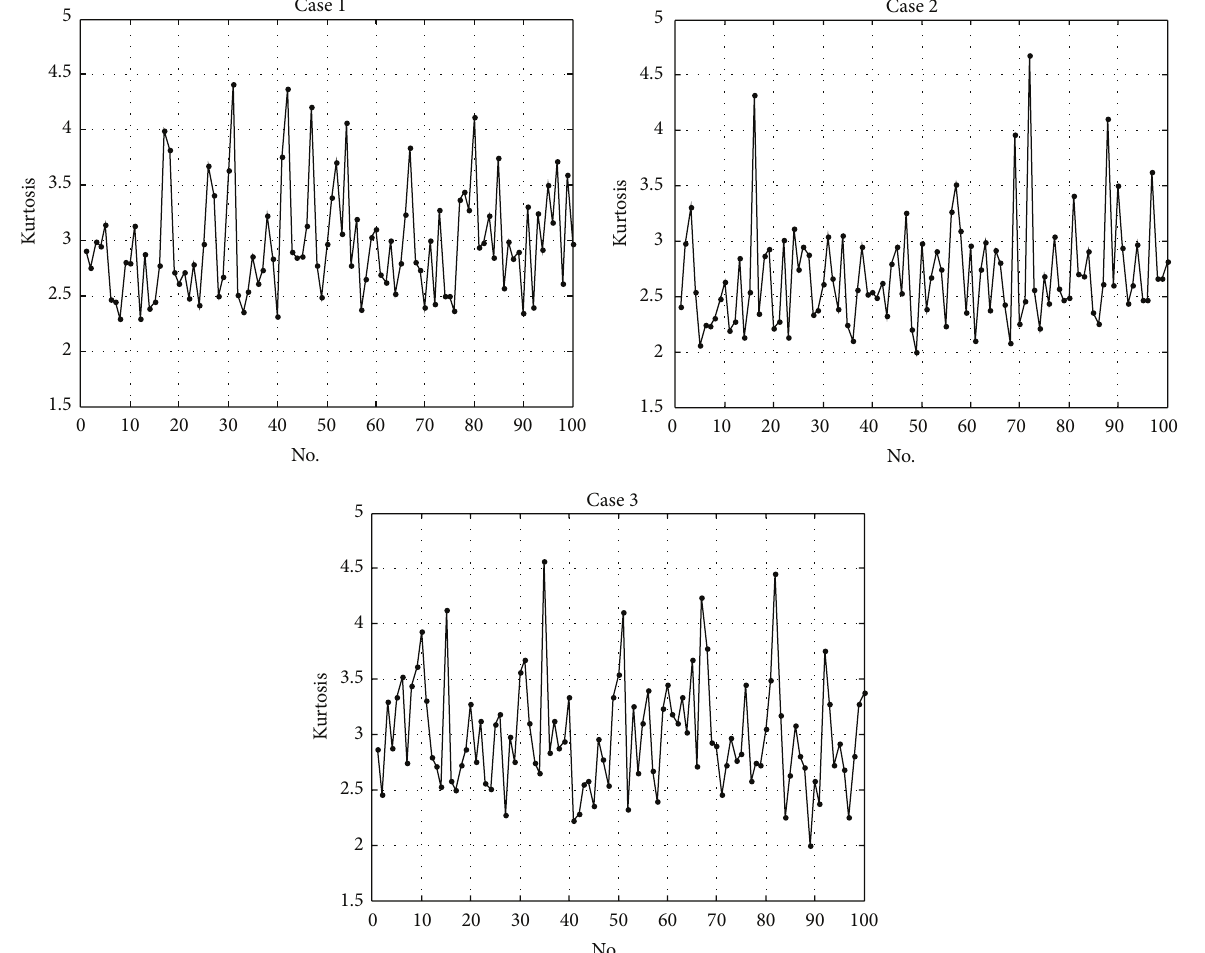
Figure 1: The kurtosis data of bearing vibration